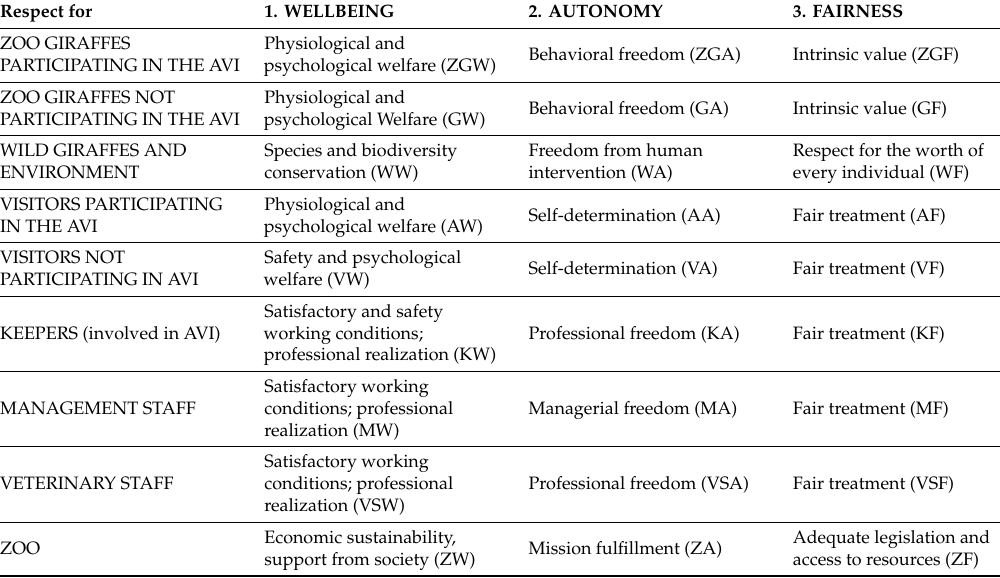
Table 2. Customized ethical